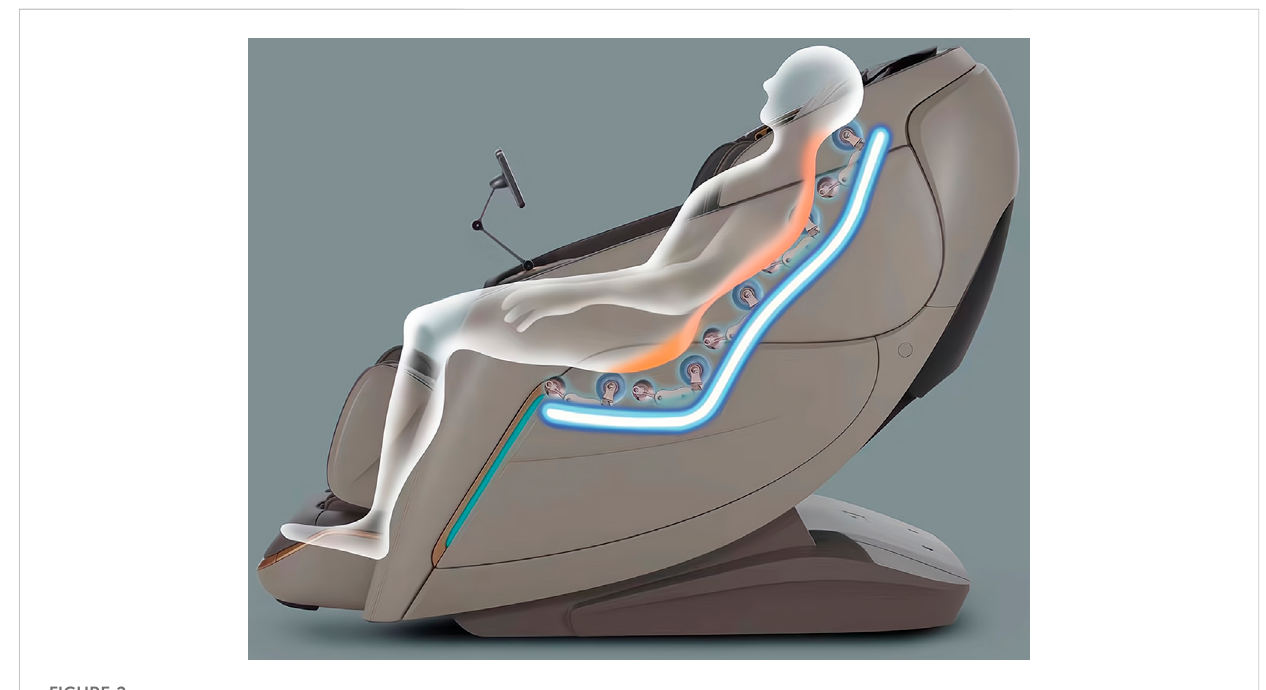
FIGURE 2 The position of mechanical arm of machine